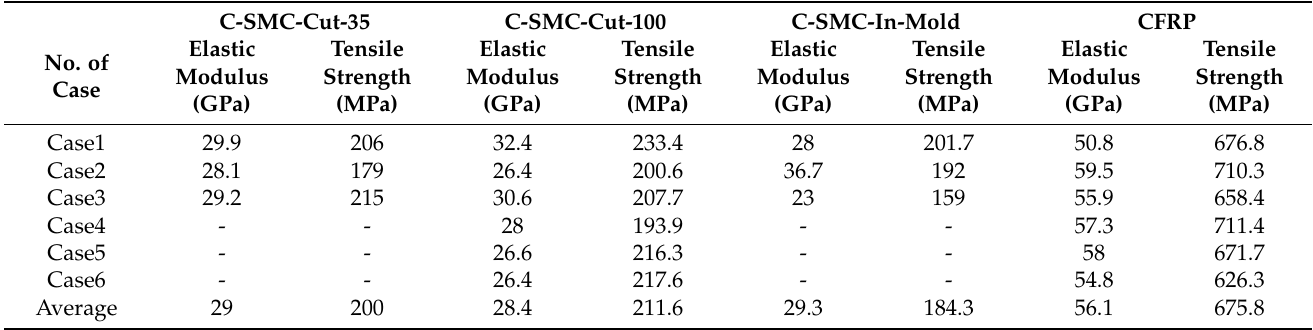
Figure 10. Stress–strain curves of the tensile test results: ( a ) C-SMC-Cut-35, ( b ) C-SMC-Cut-100, ( c ) C-SMC-In-mold, and ( d ) CFRP. Table 3. Tensile test results.